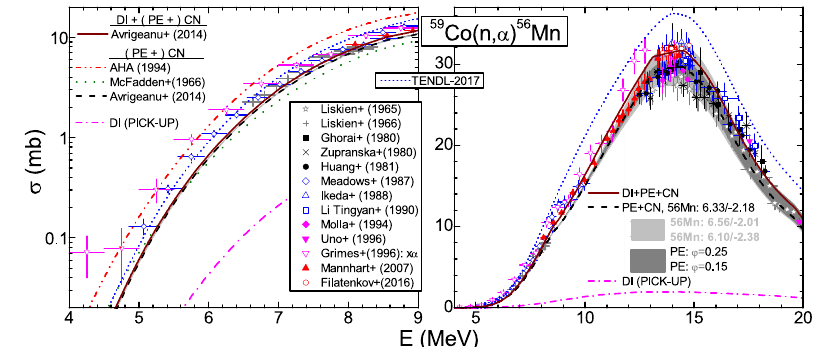
Figure 8. As Fig. 6 but for 59 Co( n ,α ) 56 Mn